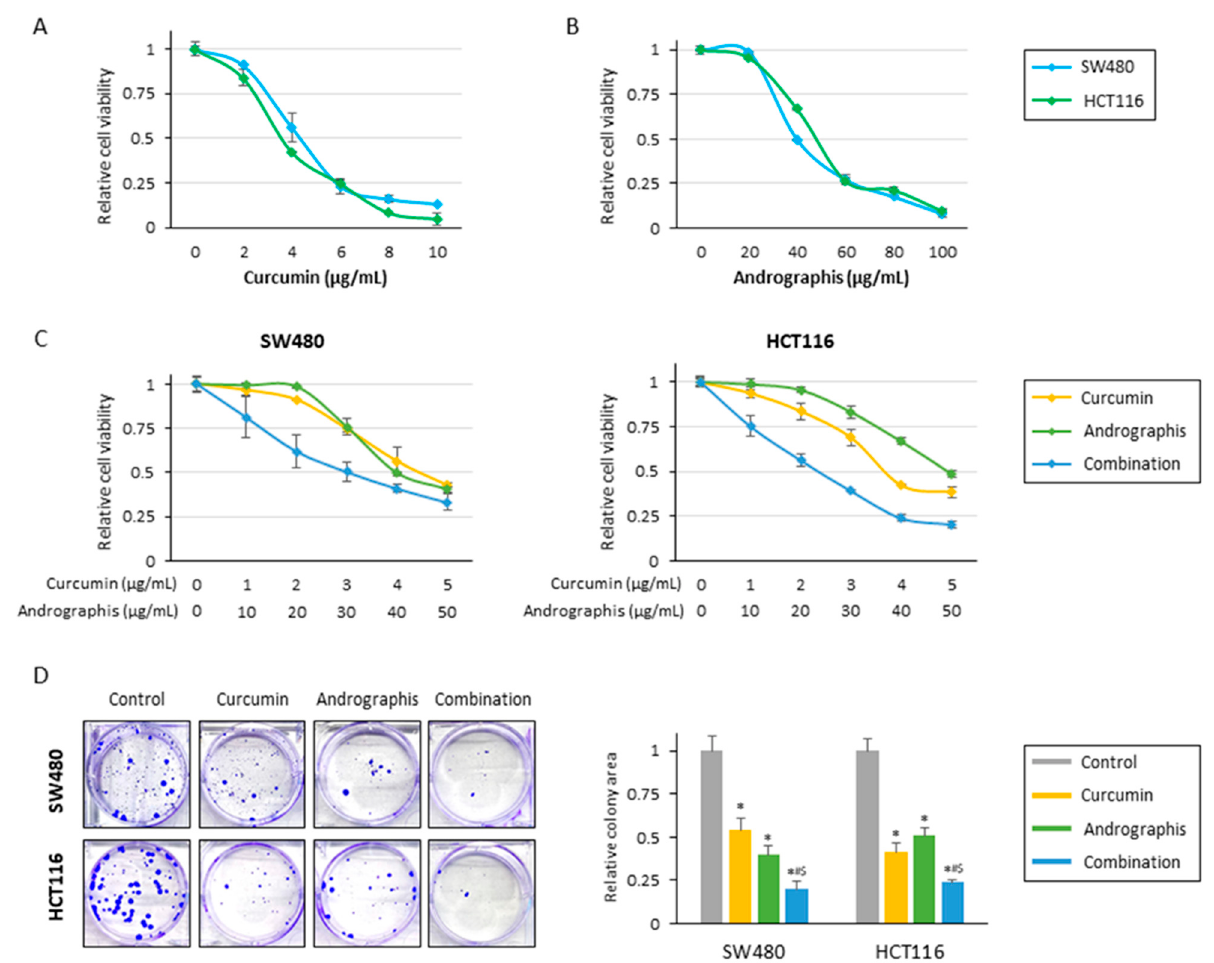
Figure 1. Curcumin and andrographis combinations exhibited an anti-tumor effect in CRC cells. ( A ) Cell viability assay following curcumin treatment for 48 h in SW480 and HCT116. The error bars represent the mean ± SD. ( B ) Cell viability assay following andrographis treatment for 48 h in SW480 and HCT116. The error bars represent the mean ± SD. ( C ) Cell viability assay following curcumin and andrographis combination treatment for 48 h in SW480 and HCT116. Error bars represent the mean ± SD. ( D ) Colony formation assays to assess the clonogenicity of CRC cells following treatment with curcumin, andrographis, and their combinations. The average (column) ± SD is indicated (*; p -value < 0.05 vs. control, #; p -value < 0.05 vs. curcumin, $; p -value < 0.05 vs. andrographis). Cur: curcumin; andro: andrographis.